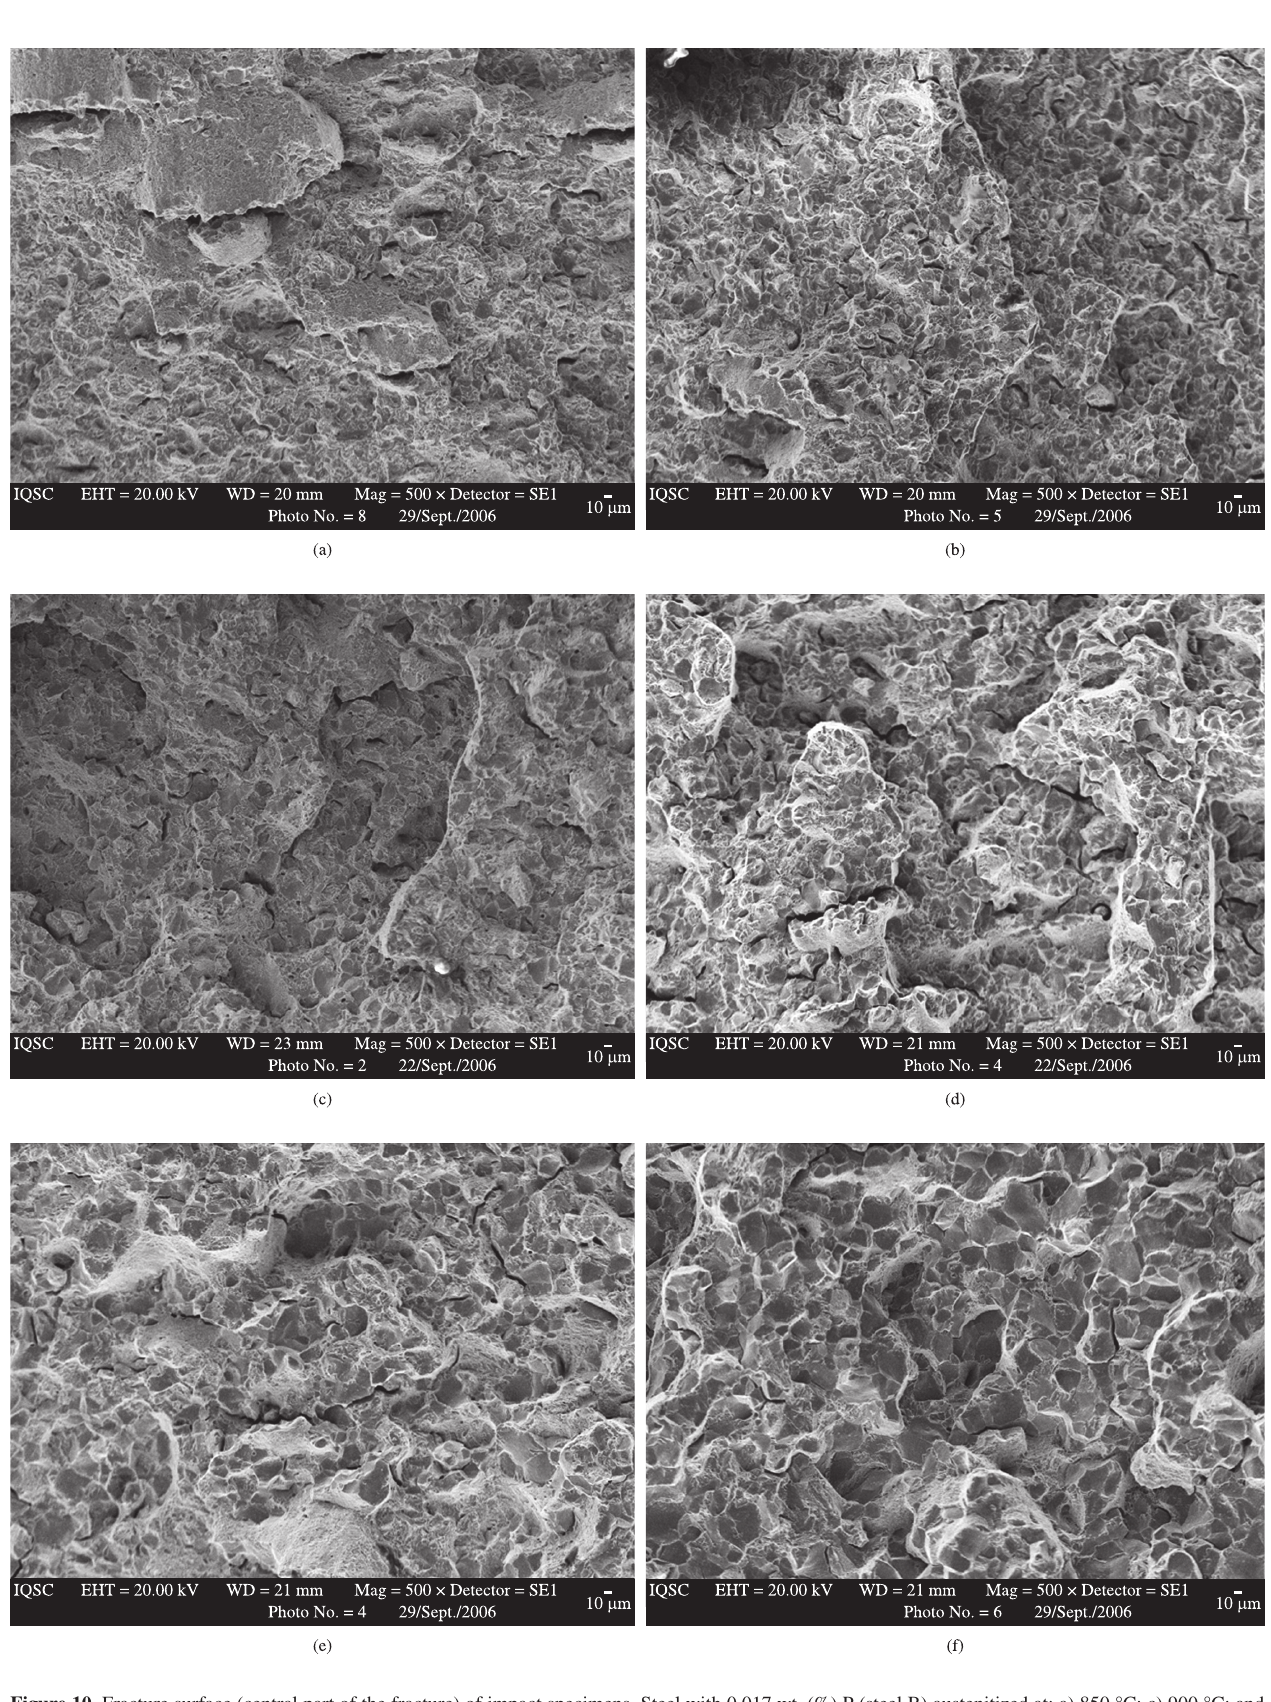
Figure 10. Fracture surface (central part of the fracture) of impact specimens. Steel with 0.017 wt. (%) P (steel B) austenitized at: a) 850 °C; c) 900 °C; and e) 1000 °C. Steel with 0.031 wt. (%) P (steel D) austenitized at: b) 850 °C; d) 900 °C; and f) 1000 °C. The specimens were tempered at 470 °C for 70